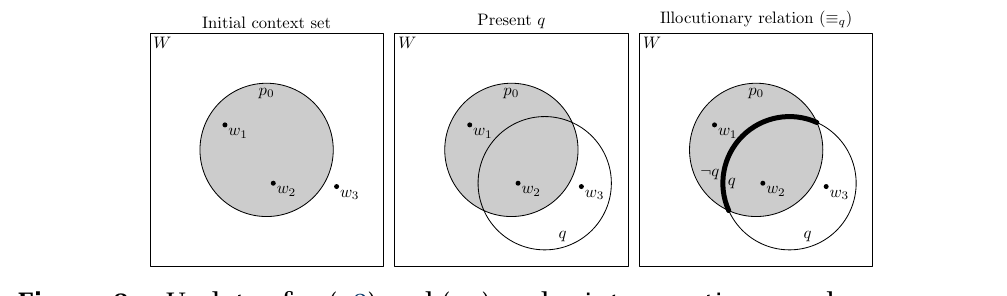
Figure 8 Updates for ( 28 ) and ( 29 ): polar interrogative